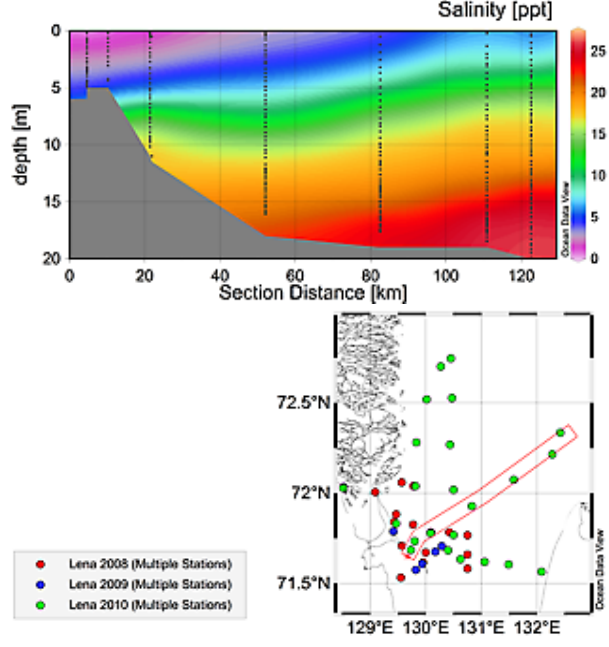
Fig. 2. Salinity for transect 1 in Buor-Khaya Bay in July 2010.